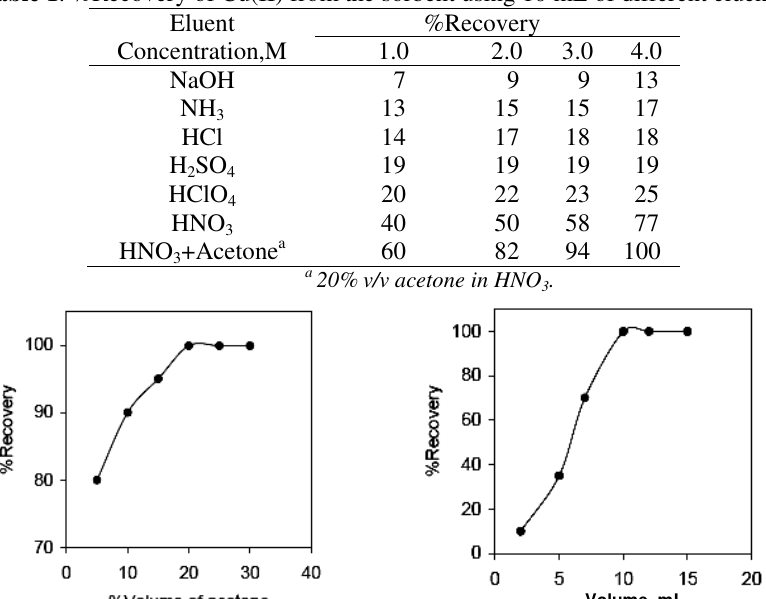
Table 1 . %Recovery of Cu(II) from the sorbent using 10 mL of different eluents.